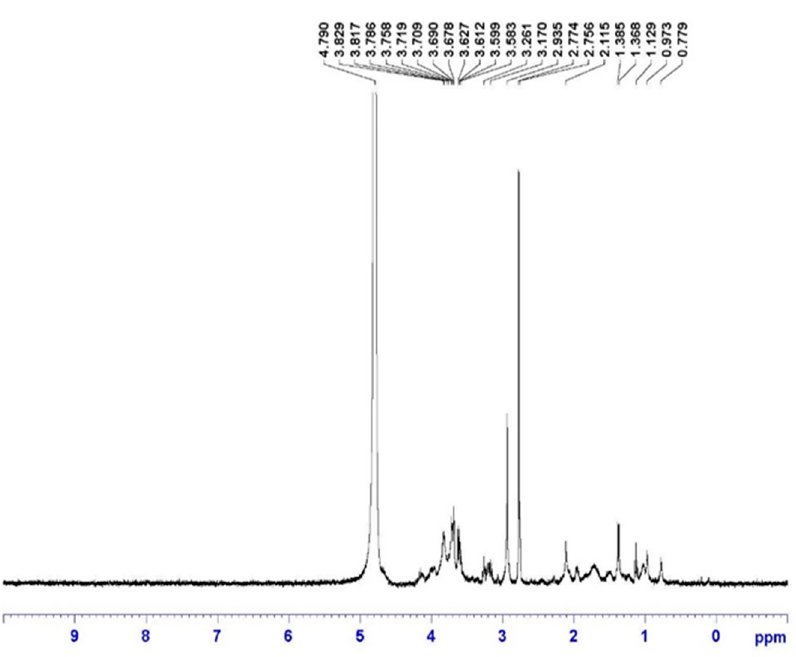
Figure 8. Proton NMR spectrum of cholic acid conjugated chitosan derivative 1 in D 2 O.